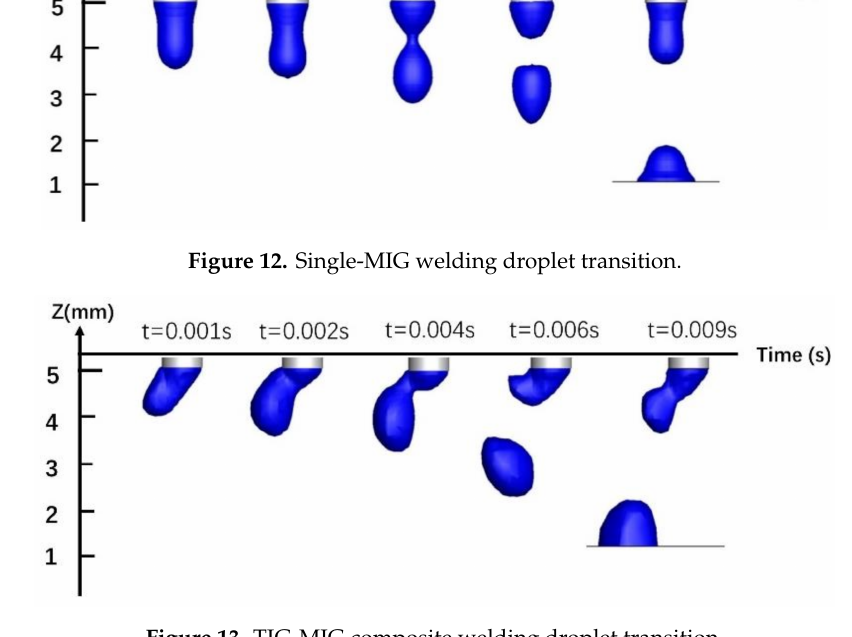
Figure 13. TIG-MIG composite welding droplet